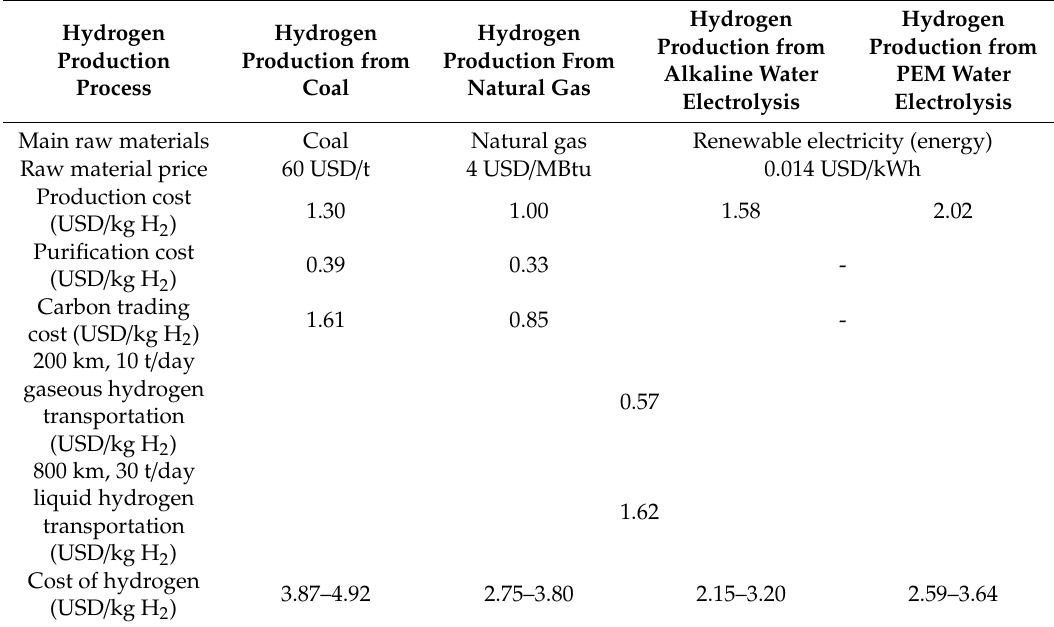
Table 10. Cost of hydrogen for fuel cell vehicles